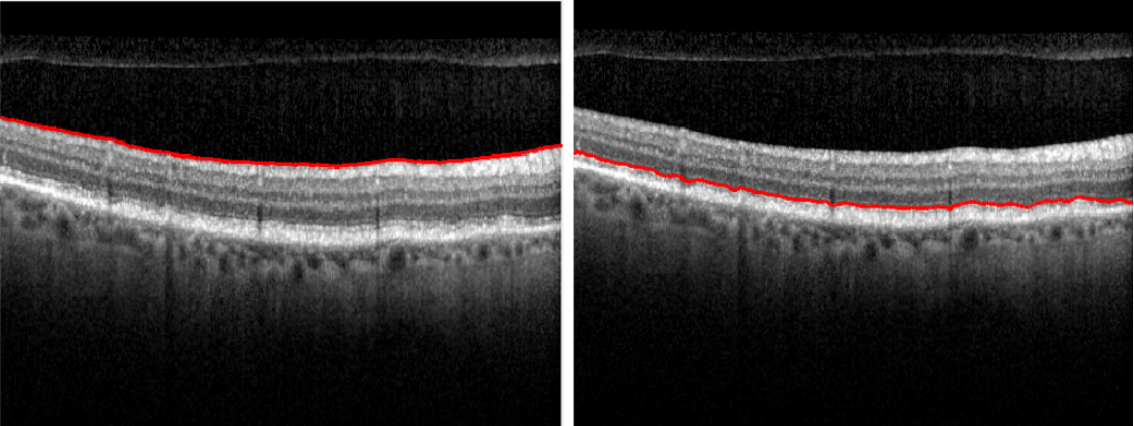
Figure 3. Example of the segmentation of the IS-OS boundary before and after the correction of the segmenting